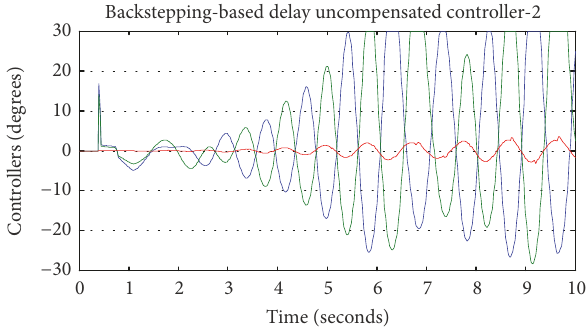
Figure 6: Uncompensated actuator deflections in extreme.